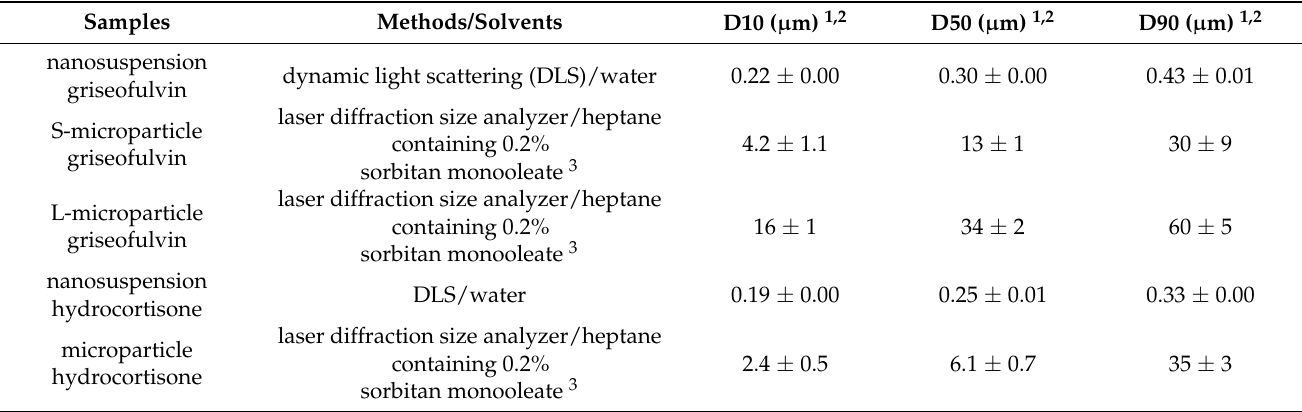
Figure 2. Particle size distribution (PSD) of: ( a ) griseofulvin samples; ( b ) hydrocortisone samples. The results were transformed to volume distribution. The PSD parameters for each sample are summarized in Table 1. The PSD of the nanosuspensions was measured by dynamic light scattering, where water was used as the solvent. The PSD of the microparticle samples was measured by laser diffraction size analyzer, where the saturated heptane solution of the compound containing 0.2% sorbitan monooleate was used as the solvent. Table 1. PSD parameters of griseofulvin and hydrocortisone samples.